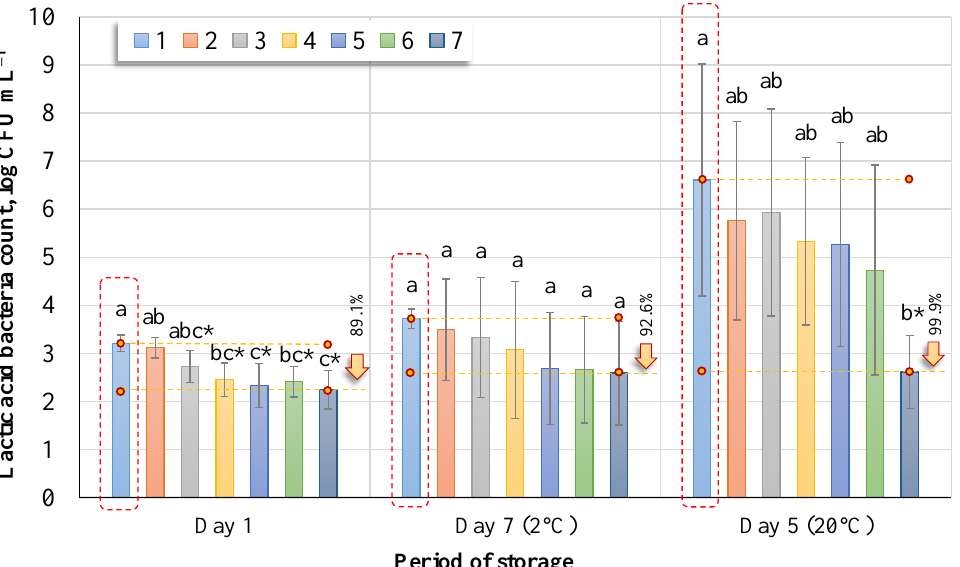
Figure 4. Changes in the lactic acid bacteria count in birch sap: 1 (control)—not ozonated sap (initial); 2—sap ozonated for 5 min; 3—sap ozonated for 10 min; 4—sap ozonated for 15 min; 5—sap ozonated for 20 min; 6—sap ozonated for 25 min; 7—sap ozonated for 30 min. Significant, substantial differences are distinguished by different letters (Tukey HSD test). Single letters indicate that there is no significant difference. Differences were considered significant when p values were less than 0.05 ( n = 18). In the Dunnett test, significant differences between the control group (No. 1) and the treatment group are marked with an asterisk “*” .